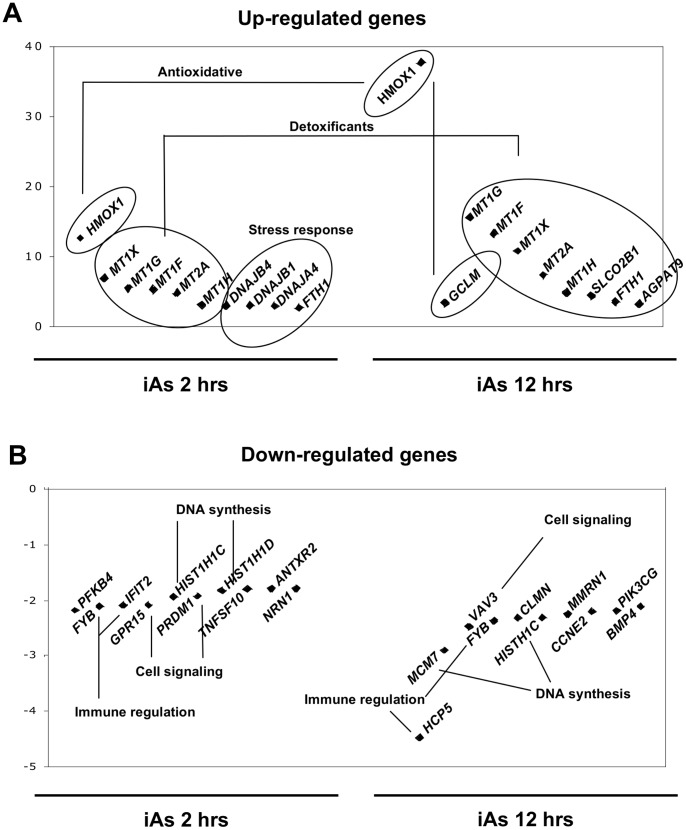
Major genes altered by iAs exposure.Cellular functions performed by the proteins encoded for the ten most up-regulated (A) and down-regulated (B) genes after 2 and 12 hrs of exposure to 5 µM of iAs.